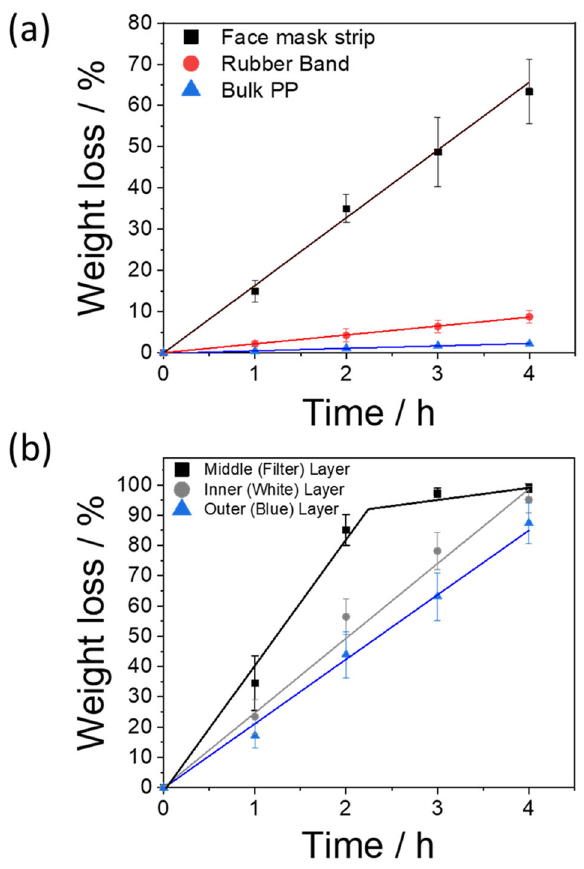
Fig. 3 Degradation of masks components. a Comparison of the percentage of mass loss for face mask strips (black squares), face mask elasticated ear loops (red circles) and bulk PP against time (blue triangles). The mass loss rates reported in the text are given by the slopes of the individual lines. b Comparison of the percentage of mass loss of the three different layers comprising the face mask against time. The error bars represent the standard derivation of the data